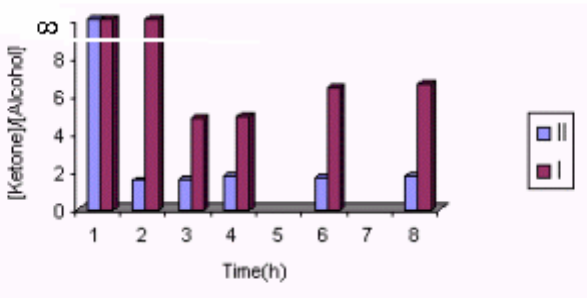
Figure 9. Variation of the [acetophenone] / [1- phenylethanol ] ratio vs. time for experiments 3 and